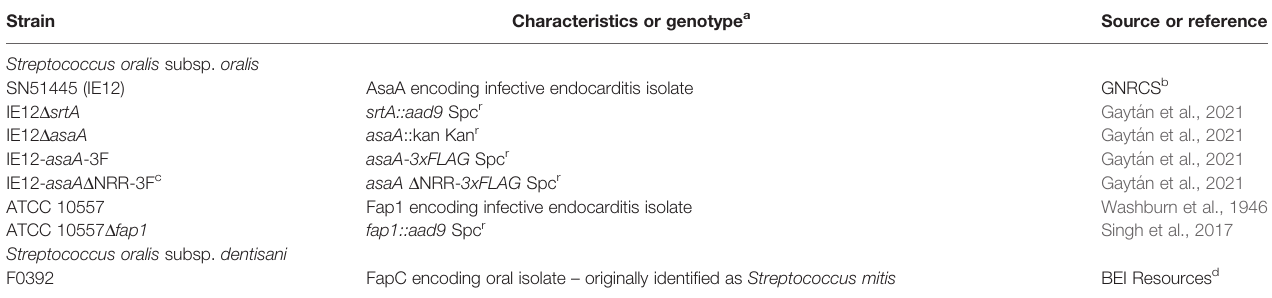
Table 1 . The Streptococcus oralis subsp. oralis isolates